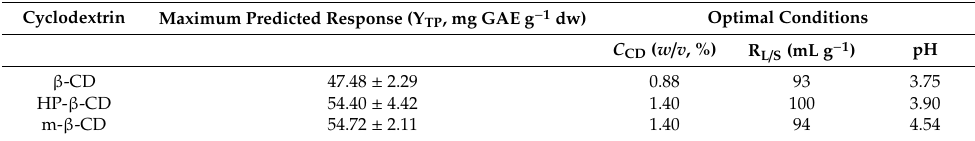
Figure 3. Desirability function for each of the CDs tested, displaying optimal conditions and maximum predicted response values. Assignments: m- β -CD, methyl β -cyclodextrin; HP- β -CD, hydroxypropyl β -cyclodextrin; β -CD, β -cyclodextrin. Table 5. Values of the optimal predicted conditions and maximum predicted Y TP ( ± sd) for S. fruticosa polyphenol extraction by the CDs